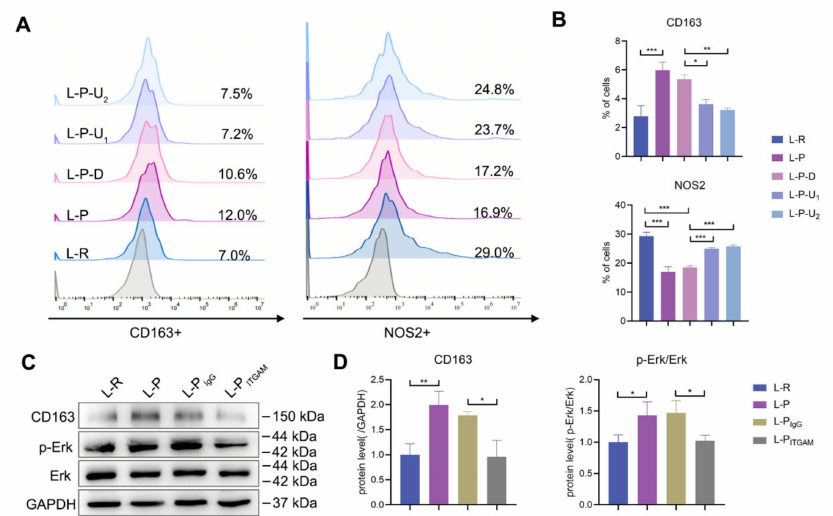
Figure 6. Periostin reprogrammed macrophages partly through integrin α M/p-Erk/Erk signaling. ( A , B ) Flow cytometric analysis for pro- and anti-inflammatory marker expression in macrophages after periostin stimulation with or without Erk inhibitor. The data were analyzed by one-way ANOVA and Bonferroni post hoc test (n = 3). L-R: group treated with RPMI1640 alone; L-P: group treated with rhPeriostin; L-P-D: group treated with rhPeriostin and DMSO; L-P-U 1 : group treated with rhPeriostin and 10 µ g/mL U0126; L-P-U 2 : group treated with rhPeriostin and 20 µ g/mL U0126. ( C , D ) Western blot analysis of CD163 and phosphorylation of ERK in macrophages after periostin stimulation with or without anti-ITGAM antibodies. IgG isotype control or anti-ITGAM antibodies were added to examine the role of integrin α M in signaling. The data were analyzed by one-way ANOVA and Bonferroni post hoc test (n = 3). * p < 0.05; ** p < 0.01; *** p < 0.001. Error bars represent means ±